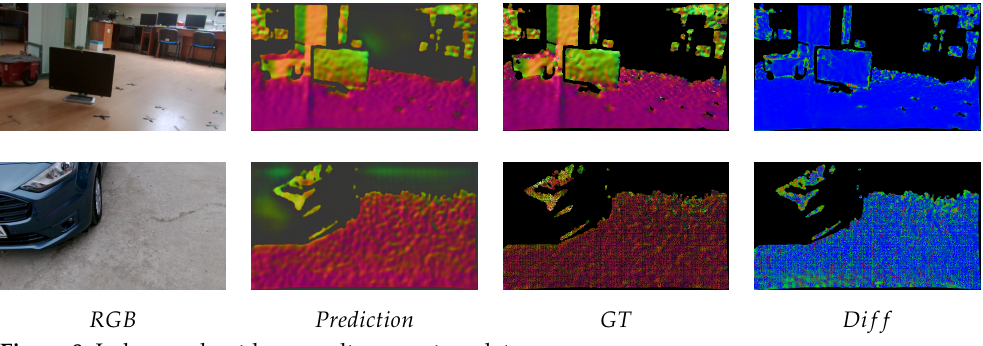
Figure 8. Indoor and outdoor results on custom data. Table 3. Summary of the custom Indoor/Outdoor evaluation for normal